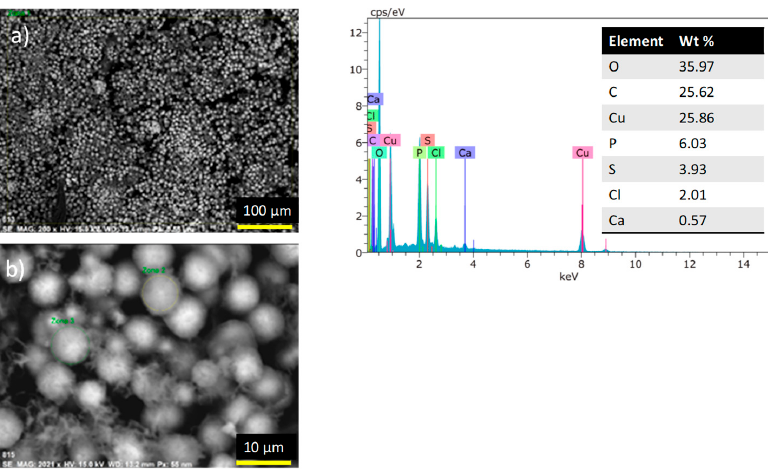
Figure 9. SEM-EDS image of complex 1a -Cu, scale: ( a ) 100 μ m, ( b ) 10 μ m.